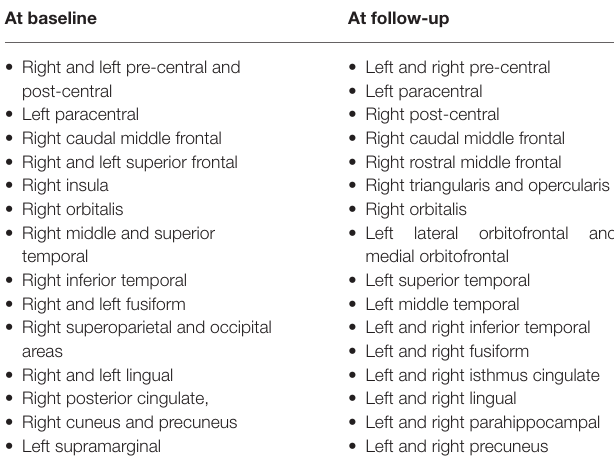
• Left and right precuneus